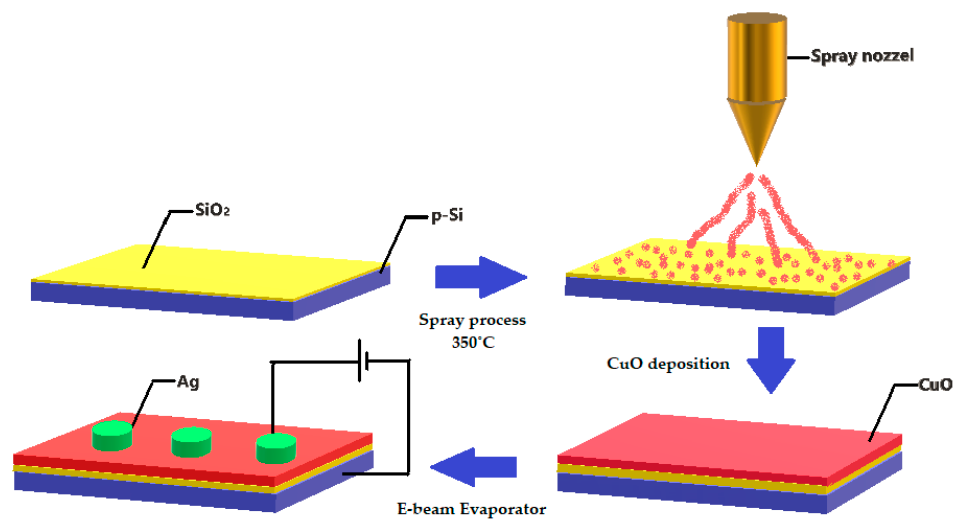
Figure 1. Step-by-step schematic representation of Ag / CuO / SiO 2 / p-Si device fabrication.